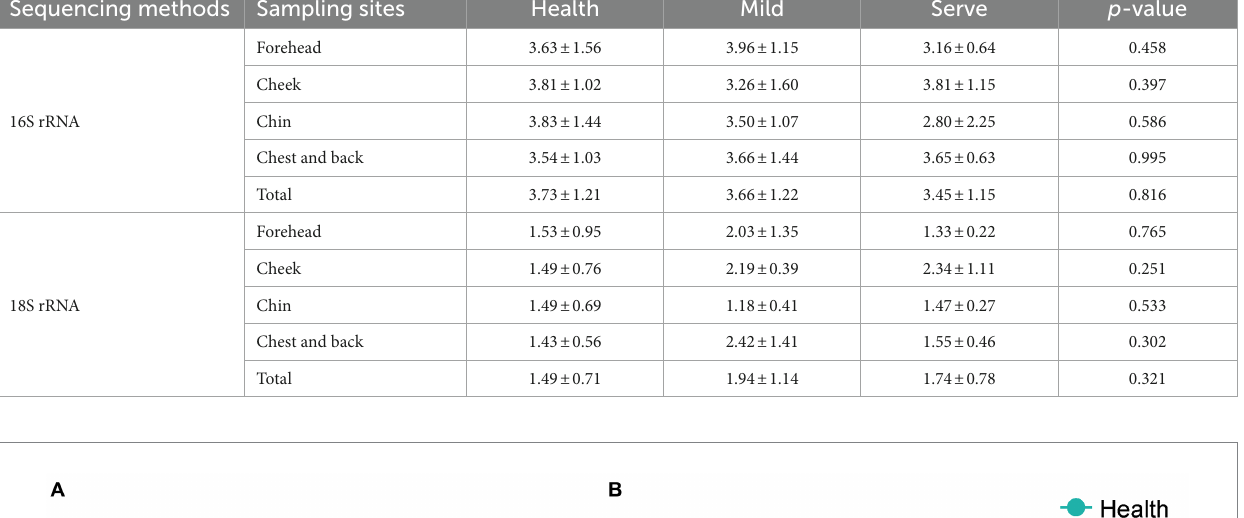
TABLE 2 The Shannon value of different groups and sampling sites. Sequencing methods